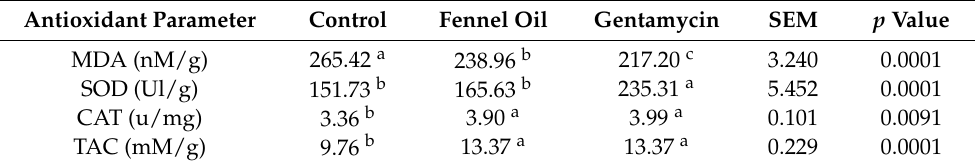
Table 8. Impact of dietary fennel oil or gentamycin on the antioxidant parameter in liver tissue of weaned Moshtohor rabbits aged 12